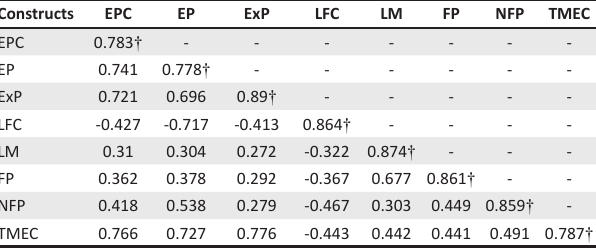
TABLE 3: Output of Fornell–Larcker criterion. Constructs